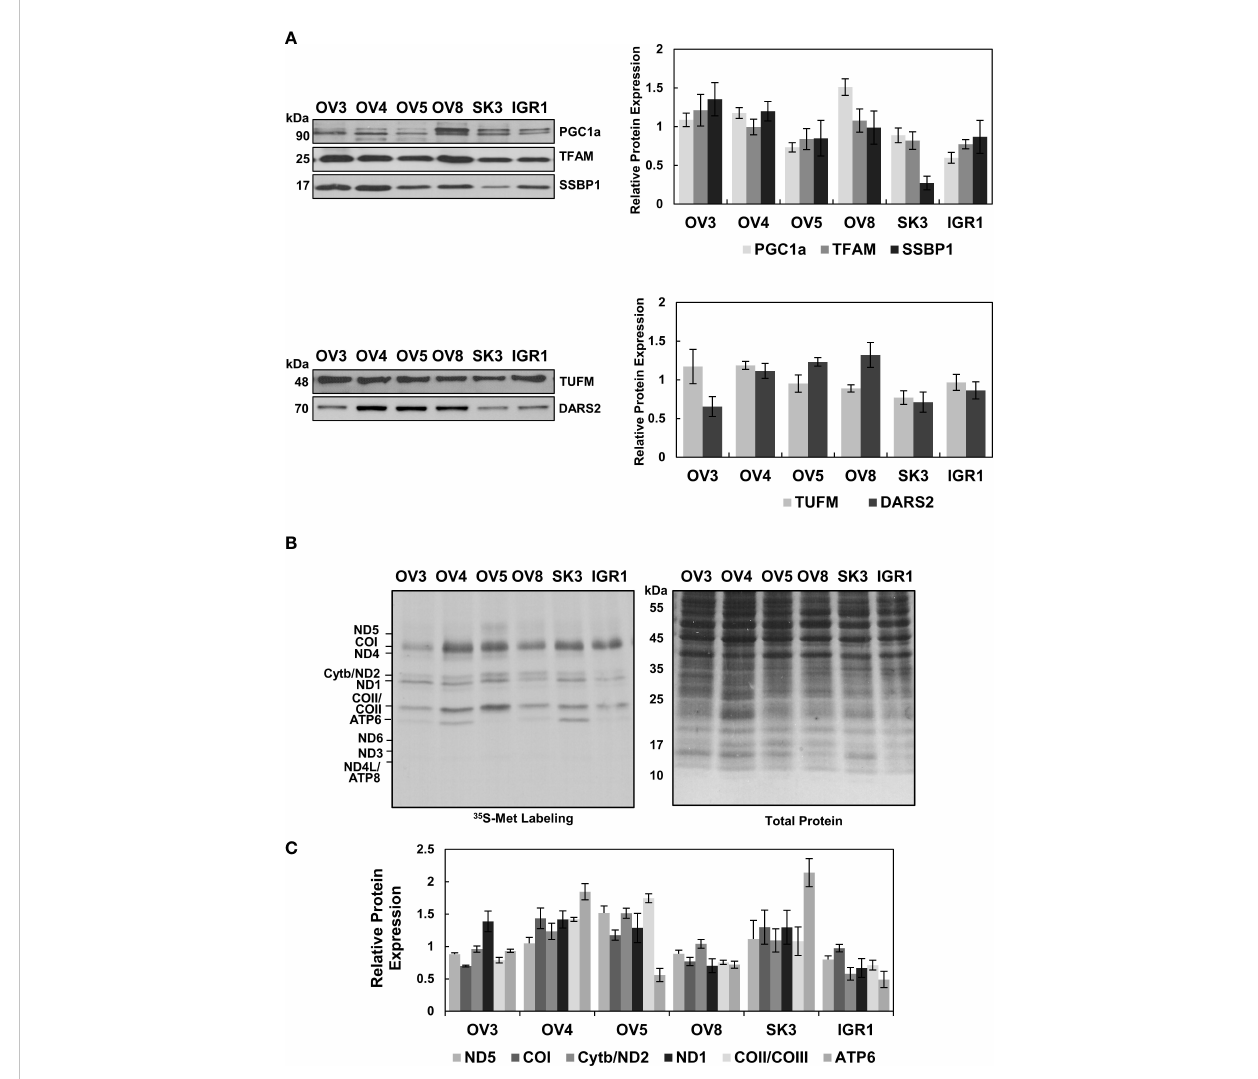
FIGURE 5 Evaluation of Mitochondrial Biogenesis in Ovarian Cancer Cell Lines. (A) Mitochondrial transcription and replication-related proteins, PGC1a, TFAM, and SSBP1, and (B) mitochondrial translation-related proteins, TUFM and DARS2, were detected by immunoblotting analyses of ovarian cancer cell lines described in Figure 4A. Ponceau S staining ensured equal protein loading Results represent the mean ± SD of at least three experiments. (C) Mitochondrial translation is determined by 35 S-Met pulse labeling of 13 mt-encoded OXPHOS subunits in ovarian cancer cell lines. The pulse-labeled protein lysates (30 m g) were separated on 13% SDS-PAGE and 13 mt-encoded subunits, ND1-ND6 (complex I), Cyt b (complex III), COI-COIII (complex IV), and ATP6 and ATP8 (complex V), were labeled on the autoradiography of the gel. Total protein loading was visualized by Coomassie Blue. The relative quantitation of de novo synthesized subunits, ND5, COI, Cyt b/ND2, ND1, COII/COIII, and ATP6, was determined from at least three experiments, with the mean ± SD displayed. The signal intensity of each protein band was normalized to the mean of high (OV3, OV4, and OV5) or low (OV8, SK3, and IGR1) OXPHOS expressing cell